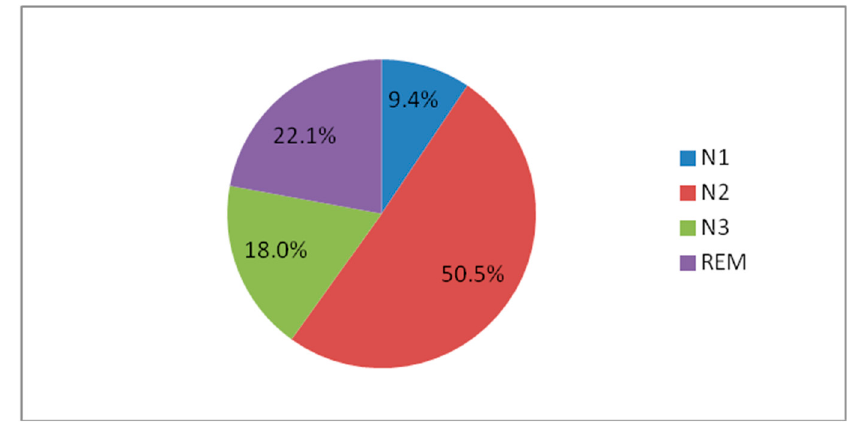
Figure 3. Sleep microstructure. N1, non-rapid eye movement stage 1; N2, non-rapid eye movement Table 3. Polysomnography report.